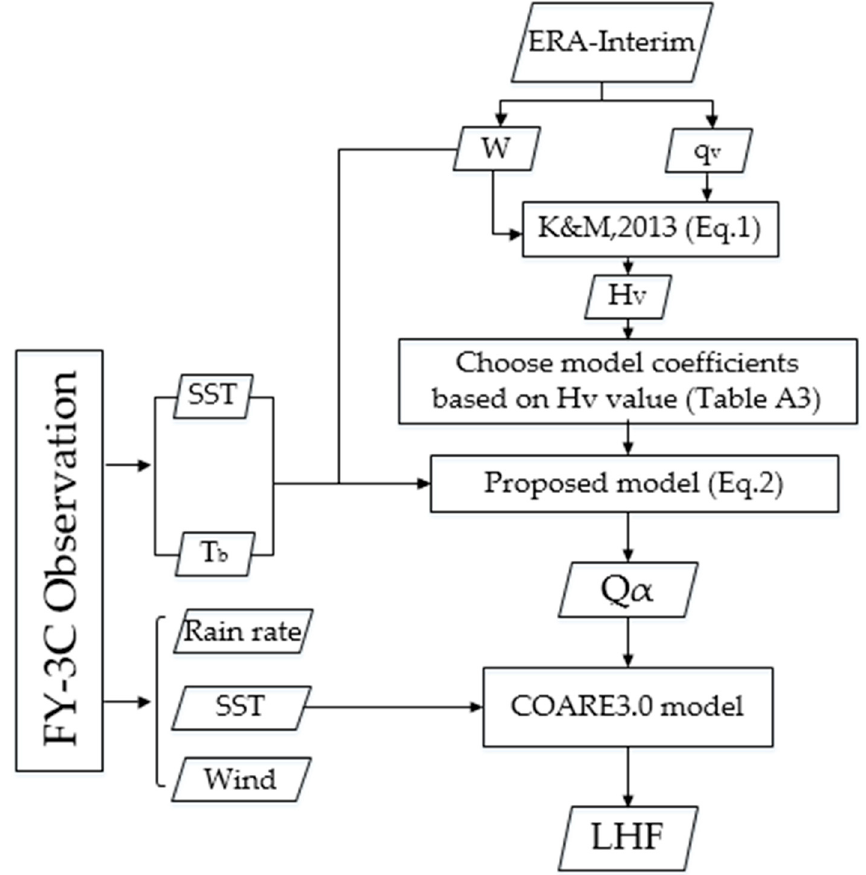
Figure 1. Methodological framework to estimate global air–sea Q a and latent heat flux (LHF) using FY-3C satellite observations.